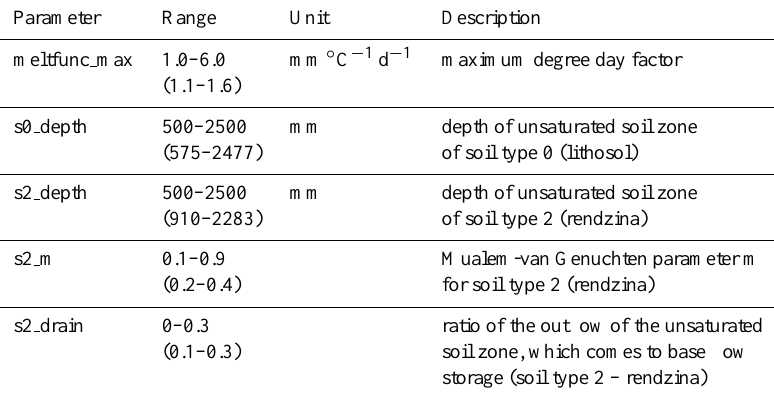
Table 1. Parameters and their ranges used for uncertainty analysis. Values in brackets indicate the range of the 20 parameter